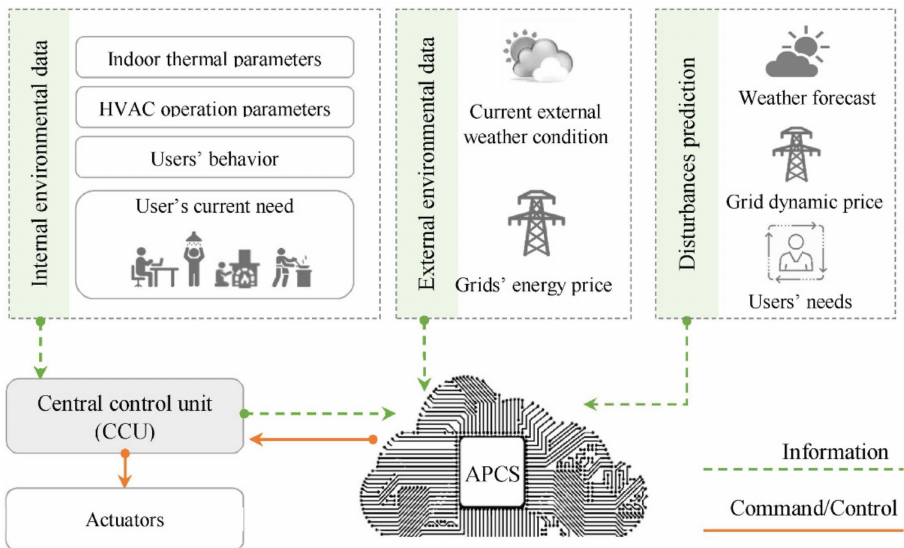
Figure 3. Application of adaptive–predictive control strategies (APCS) as a supervisory control system through a cloud platform [7].